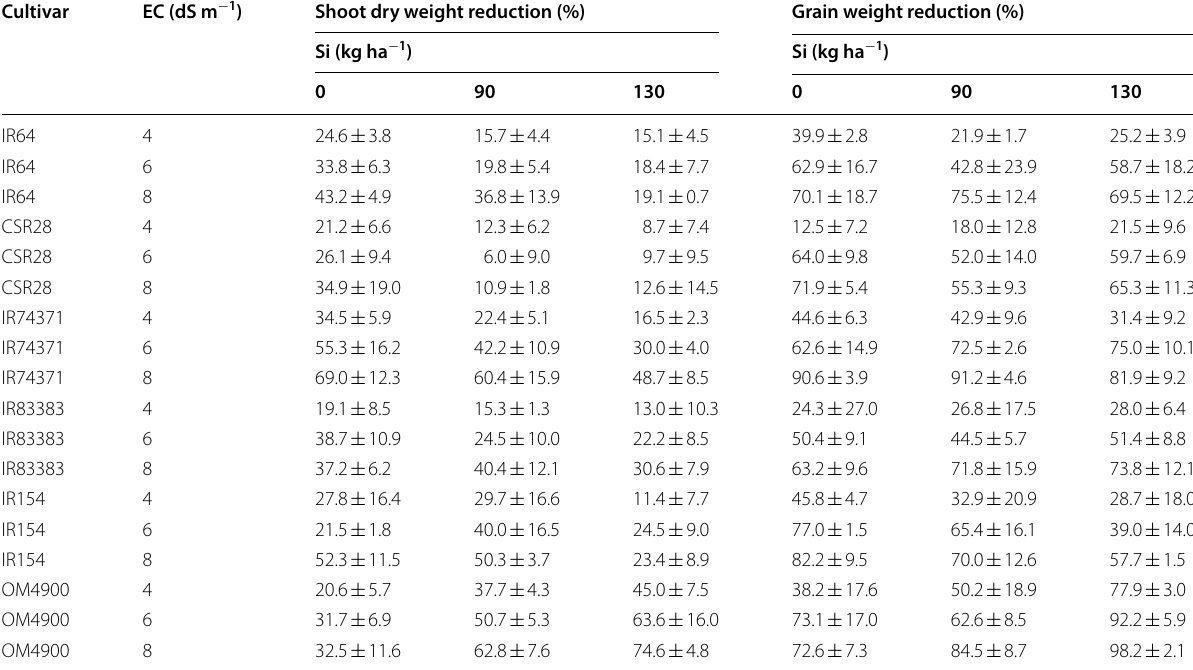
Plants were soil grown on four levels of salinisation (EC of 0, 4, and 6 dS m − 1 ) and three levels of Si fertilisation (0, 90 and 130 kg ha − 1 ). The effect of Si is expressed as percentage reduction, relative to the ‘no Si added’ condition